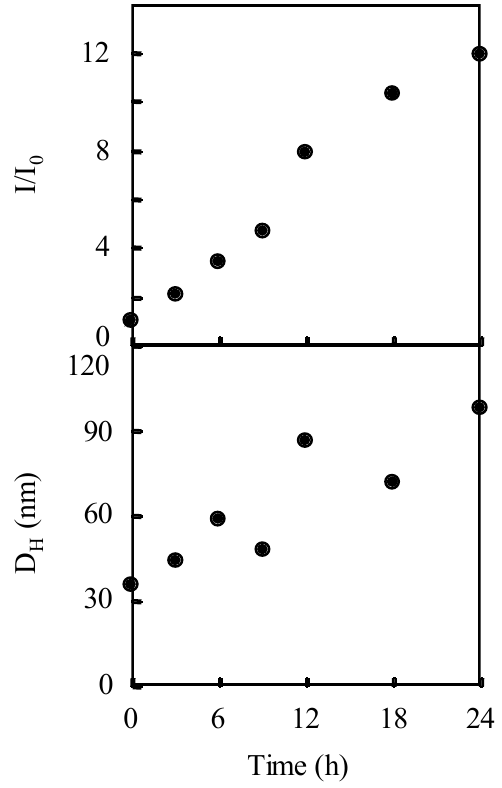
Figure 15. The variation in the relative scattering intensity and hydrodynamic diameter of the copolymer. [copolymer] = 1.64 g/L. 0